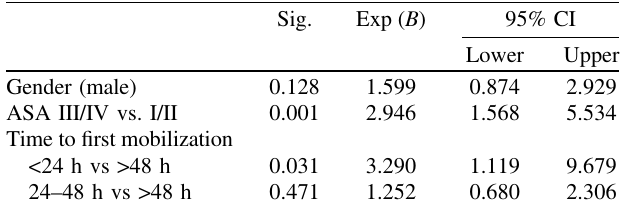
Table 2. Predictors for